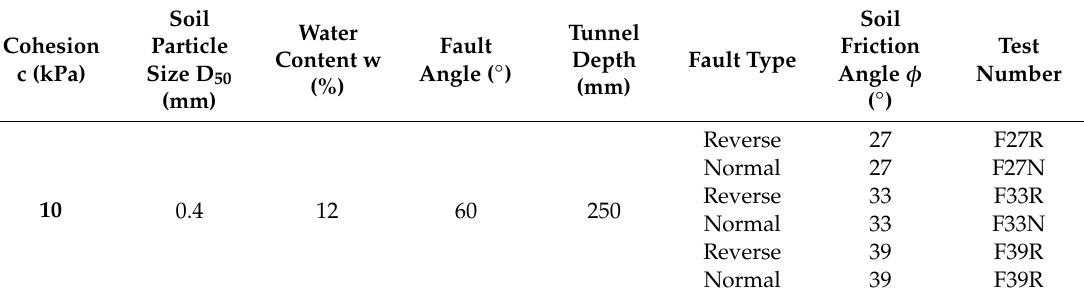
Table 4. Soil properties used for various soil friction